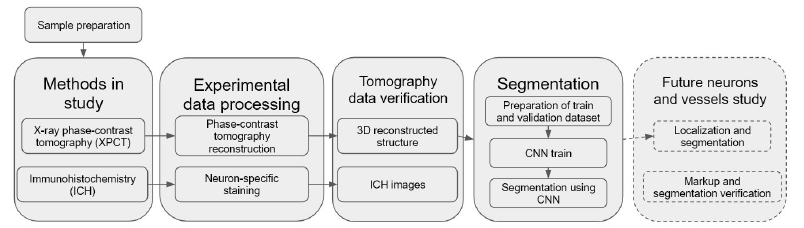
Figure 1. Illustration of the pipeline for segmentation of the OB using